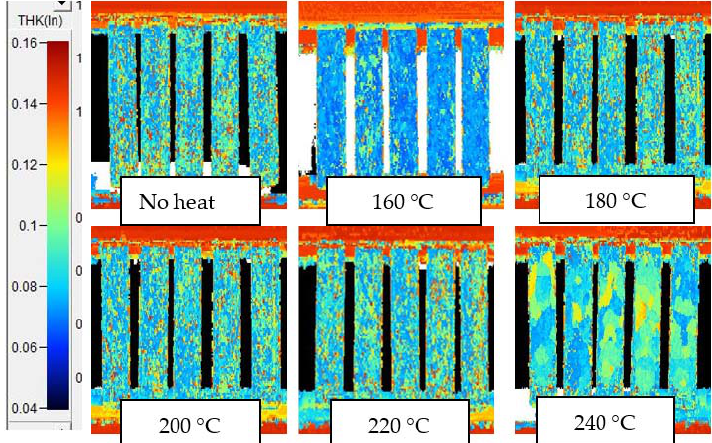
Figure A6. C ‐ scan images of samples after 1 h exposure based on time ‐ of ‐ flight to maximum interior echo.